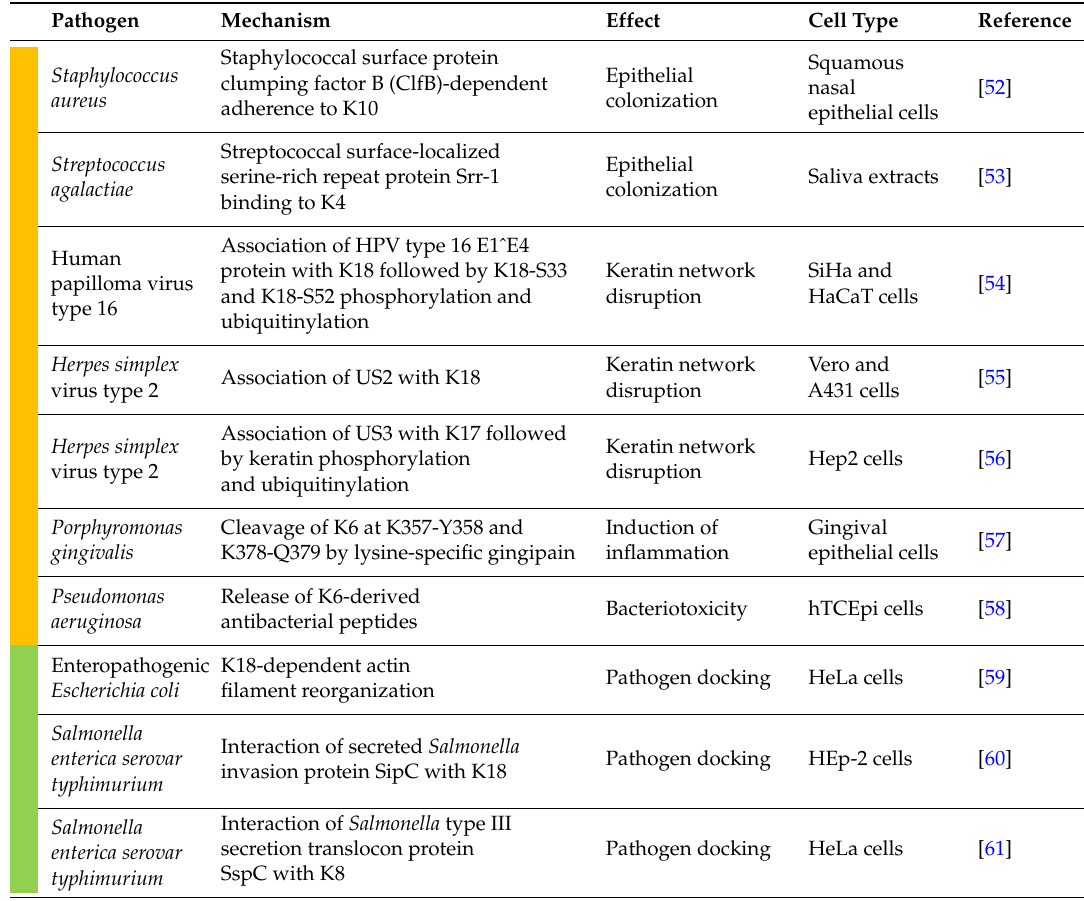
Table 1. List of specific pathogen-keratin interactions in stratified (orange) and simple (green)